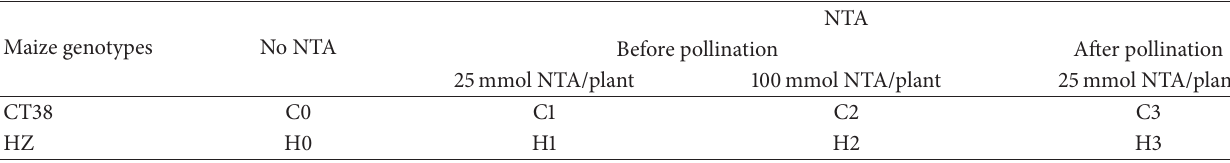
Table 2: Test design and treatments code.